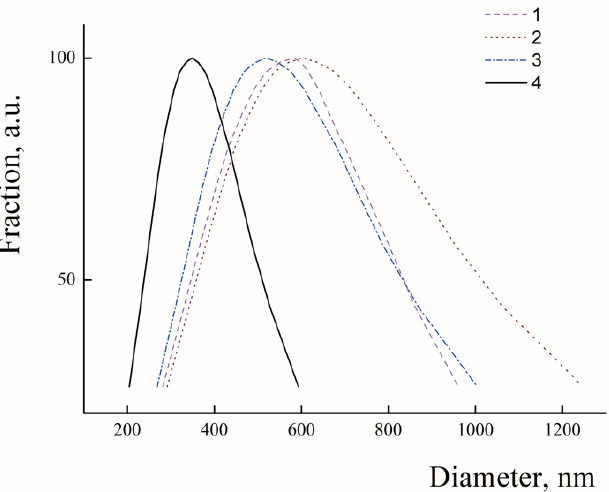
Figure 2. Size distributions in suspensions of PLAMs–cl (1); PLAMs–v (2); PLAMs–sb (3); and PLAMs–us (4). Concentration of PLAMs 0.5 mg/mL, Tris buffer with pH 7, 25